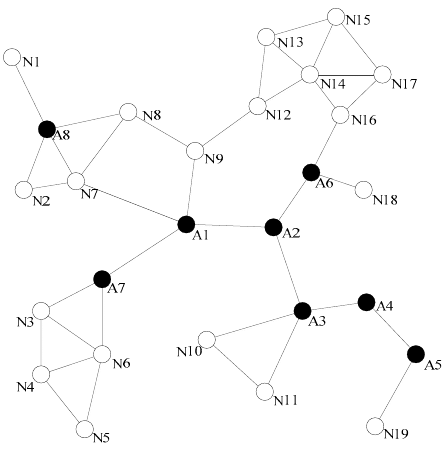
Figure 3. The network topology diagram after the detection of the dominating nodes.